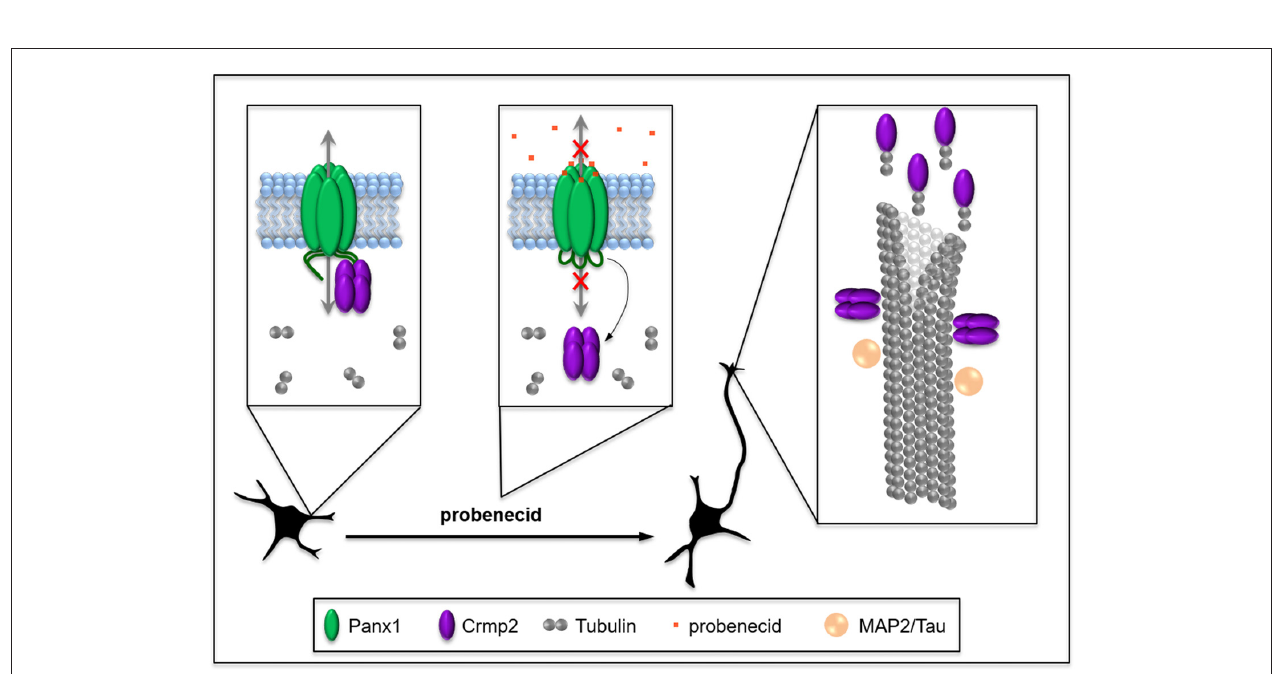
FIGURE 7 | Working model: probenecid promotes neurite outgrowth by releasing Crmp2 thereby stabilizing microtubules. Panx1, which is developmentally regulated at a cellular and tissue level in neural precursor cells (NPCs), physically sequesters Crmp2, thereby inhibiting neuritogenesis until appropriate connections can be made. Probenecid binds to the first extracellular loop causing allosteric disruption of Crmp2 binding to the CT and resulting in a “release” of Crmp2 from the Panx1/Crmp2 complex. Free Crmp2 facilitates tubulin polymerization, and microtubule stabilization and bundling, thereby promoting neurite extension. MAP2 and Tau are microtubule-associated proteins that also contribute to microtubule stabilization in different types of neurites in the CNS and are included for context.